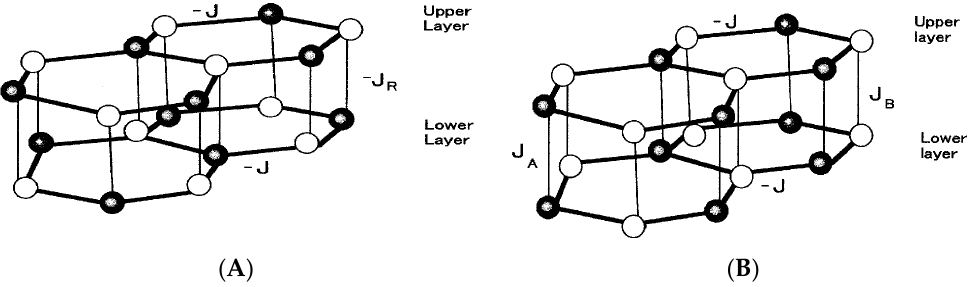
Figure 1. Schematic representations of two mixed spin Ising ferrimagnetic models on two (upper and lower) layered honeycomb lattices with spin-1/2 (white circle) and spin-1 (black circle) atoms. ( A ) Each Ising spin on upper layer is coupled to the corresponding same spin on the lower layer with an exchange interaction- J R ( J R > 0.0). ( B ) Two exchange interactions ( J A > 0.0 and J B > 0.0) exist between the two layers, depending on where the pair is located. J A is the interlayer coupling between the spin-1 atoms and J B is the interlayer coupling between the spin-1/2 atoms.